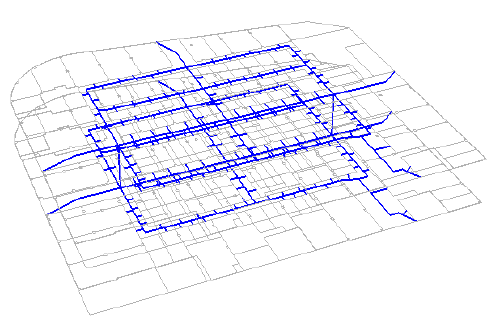
Figure 8 The result of building indoor route model